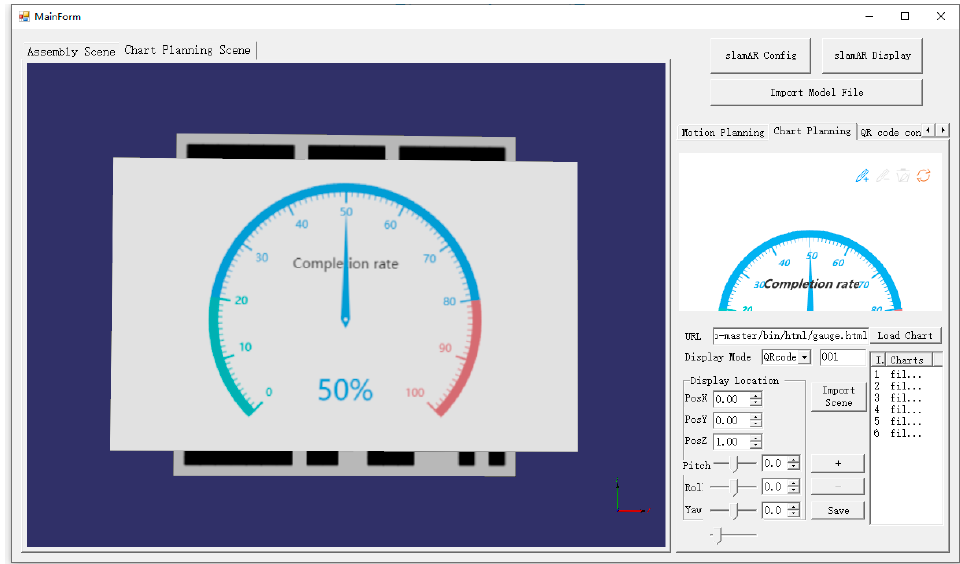
Figure 5. Industrial virtual instrument planning interface.